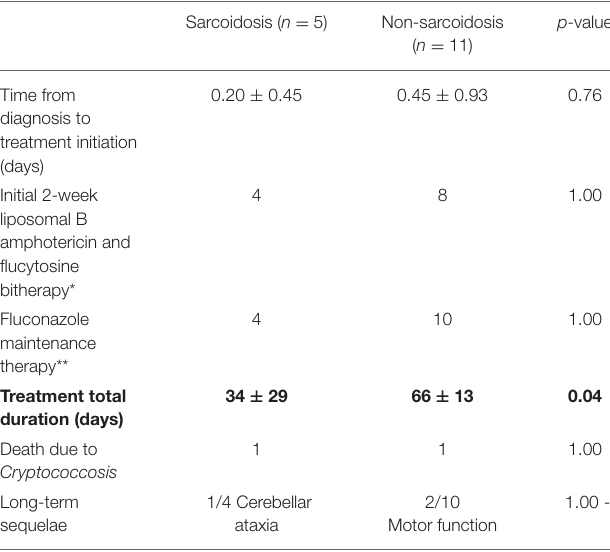
TABLE 4 | Management and outcomes of Cryptococcus spp. infection of the central nervous system. Sarcoidosis ( n =